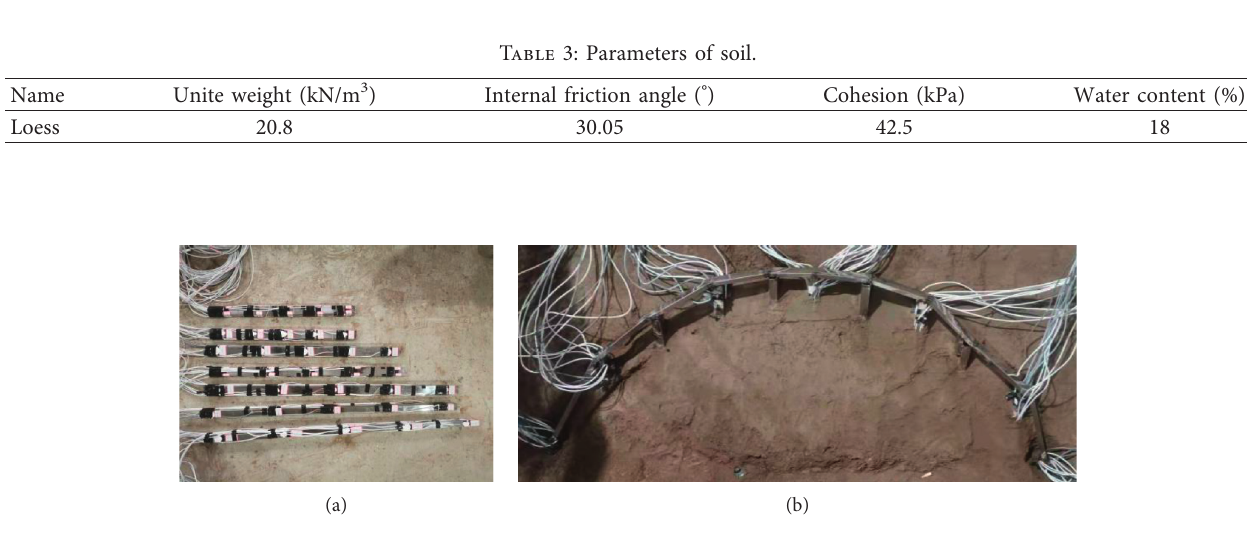
Figure 15: Supporting structure: (a) antislide piles and (b) coupling beam.